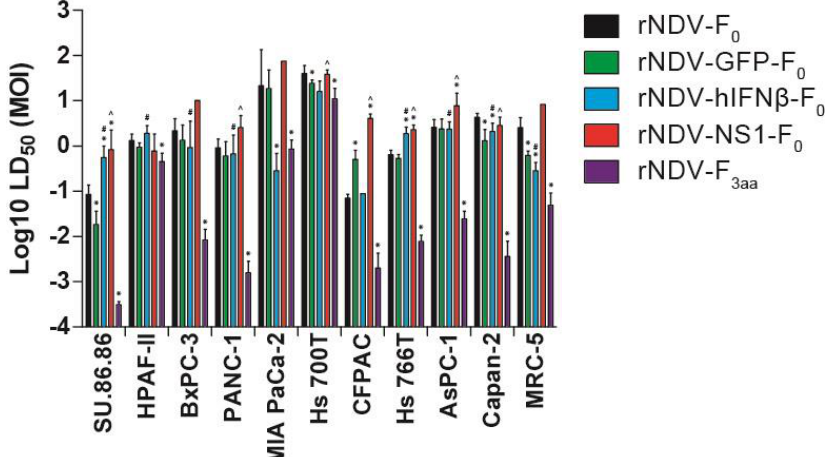
Figure 4. Median LD 50 upon inoculation with rNDVs. Cells were either mock inoculated (not shown; set as 100% viable) or inoculated with rNDV at different m.o.i. (range 0.0001–100). Cytotoxicity was measured after 5 days by LDH assay and LD 50 values were calculated. Means and ranges of LD 50 calculations are plotted. * = p < 0.05 as compared rNDV-GFP-F 0 , rNDV-hIFNβ-F 0 and rNDV-F 3aa compared to rNDV-F 0. # = p < 0.05, rNDV-F compared to rNDV-hIFN β -F . ˆ = p < 0.05 rNDV-F3 compared 3aa 0 aa to rNDV-NS1-F 0